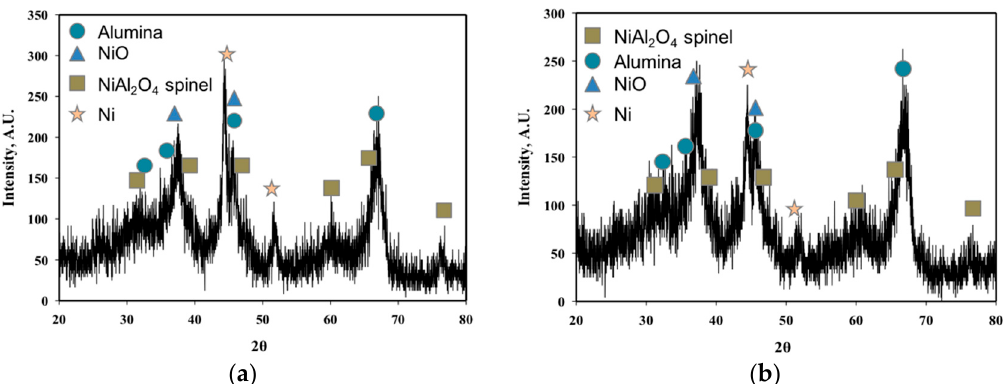
Figure 5. XRD patterns of the catalyst pellet used in toluene auto-thermal reforming, ( a ) fresh catalyst, and ( b ) used catalyst at 800 °C, S/C = 3.0, and O 2 /C = 0.2.